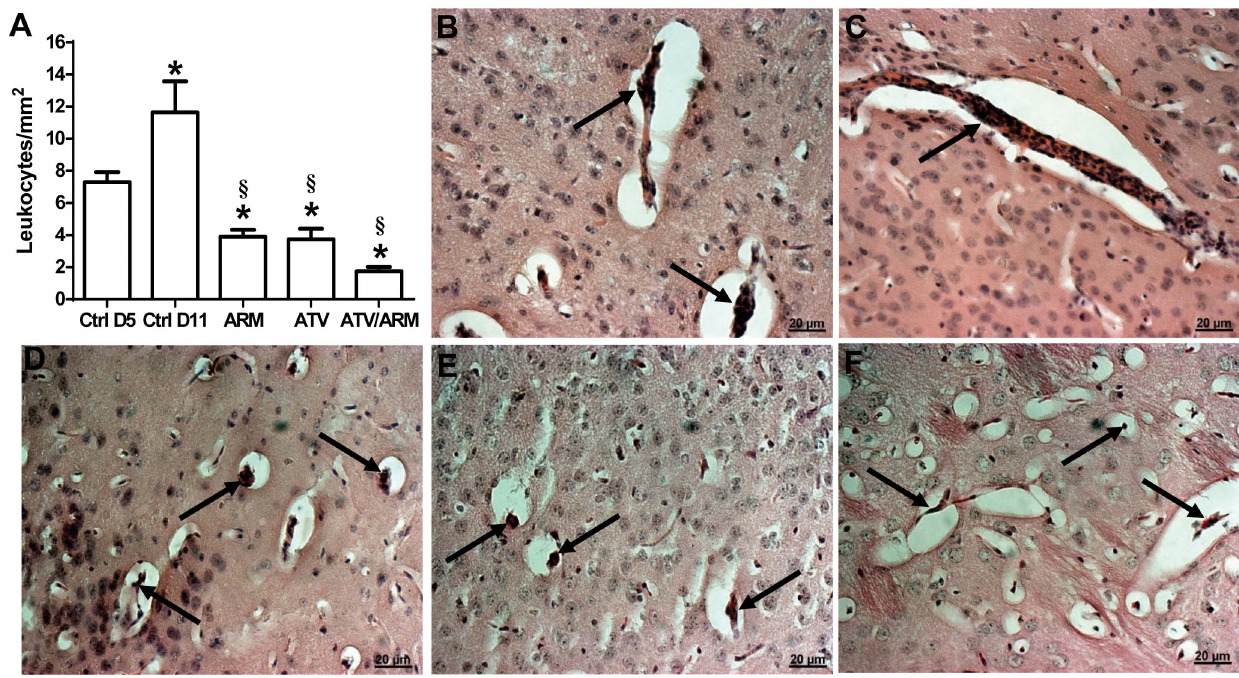
Figure 3. Inhibition of inflammation in the brain of P. berghei-infected mice with ECM after treatment. (A) The number of intravascular leukocytes per mm 2 of brain area was markedly decreased after treatment. Parenchymal vessel of (B) untreated mice with ECM on day 5 and (C) saline-treated mice on day 11, plugged with leukocytes (black arrows). Parenchymal vessels of (D) ARM-treated mice, (E) ATV-treated mice and (F) ATV/ARM-treated mice showing remnant adherent leukocytes (black arrows) on day 11. The leukocytes counts are mean 6 standard error. A p value of , 0.05 was considered significant. Asterisks ( * ) denote statistically significant change compared with ctrl D5 and section sign ( 1 ) denote statistically significant change compared with ctrl D11. Ctrl=control; D=day; ARM=Artemether; ATV=Atorvastatin.